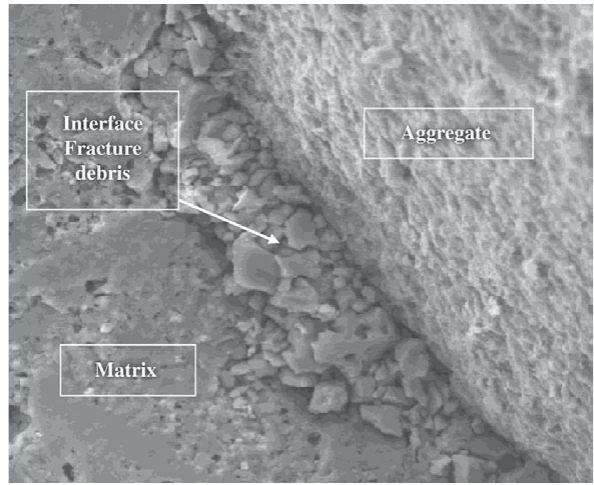
Figure 9. SEM Micrograph of fracture surface of a fired specimen (1000 °C/4 h) – Aspect ratio 3 (500×). Note the fracture debris pilled up at the